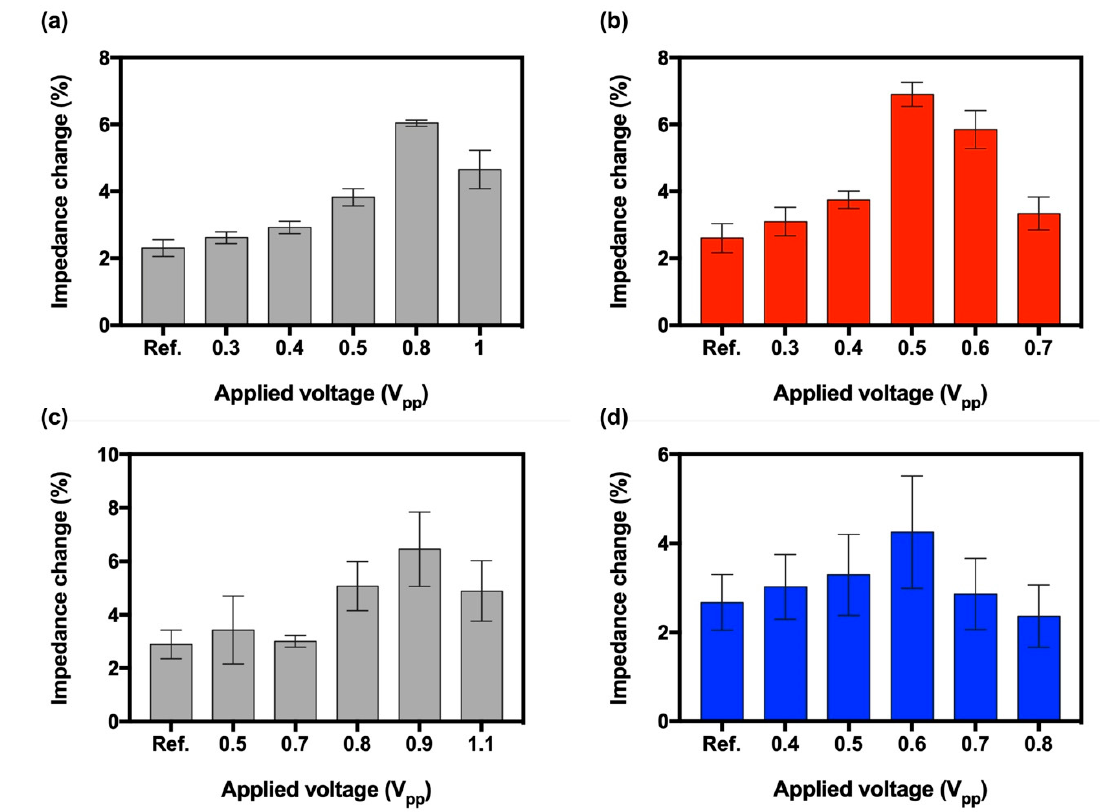
Figure 3. Optimization of the DEP condition in both patterned IMEs and bare IMEs. Impedance change by binding of A β 42 in the ( a ) bare IMEs and ( b ) patterned IMEs; impedance change by binding of tau-441 in the ( c ) bare IMEs and ( d ) patterned IMEs, respectively. Error bars indicate standard deviations of 5 independent measurements at